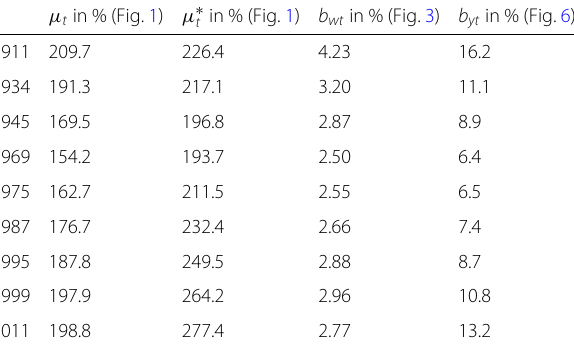
Table 1 Data points for estimated Swiss inheritance series μ μ ∗ t in % (Fig. 1) t in % (Fig. 1) b wt in % (Fig. 3) b yt in % (Fig. 6)